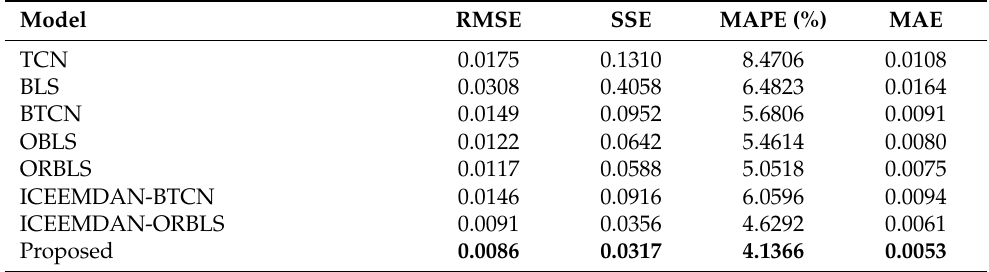
Table 5. Forecasting performances of the proposed model and reference